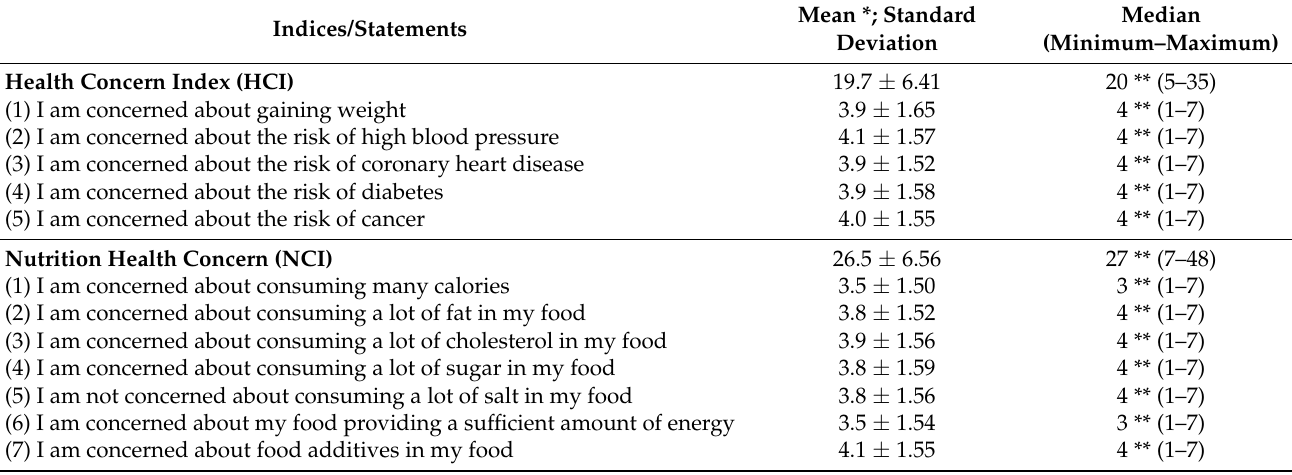
Table 3. Perceived health and nutrition concerns (mean ± standard deviation, median, minimum–maximum) *.